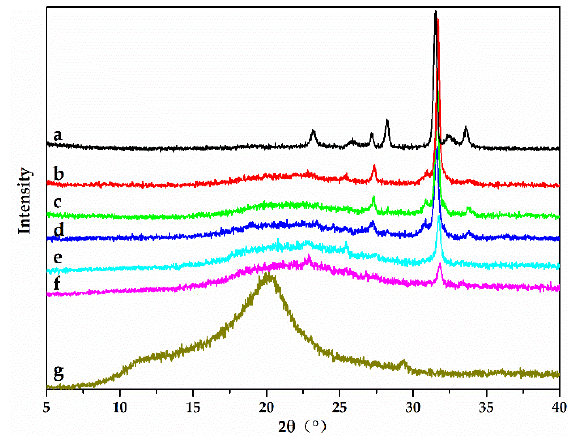
Figure 4. XRD patterns of (a) sodium lignosulfonate, L/C with different mass ratios of sodium lignosulfonate to chitosan: (b) 3:1, (c) 2:1, (d) 1:1, (e) 1:2, (f) 1:3, and (g) chitosan.